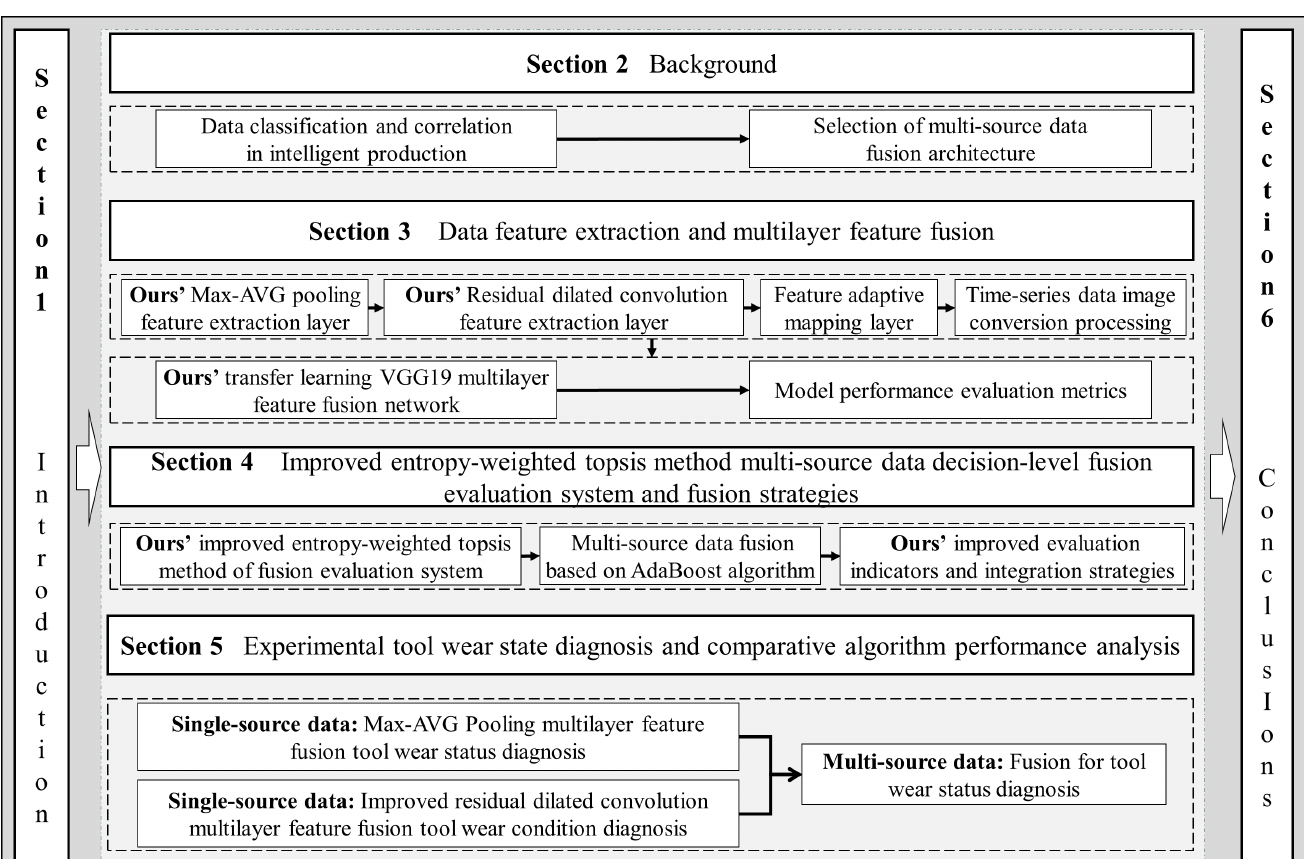
Figure 1. Overview of the structural framework and the research process of this